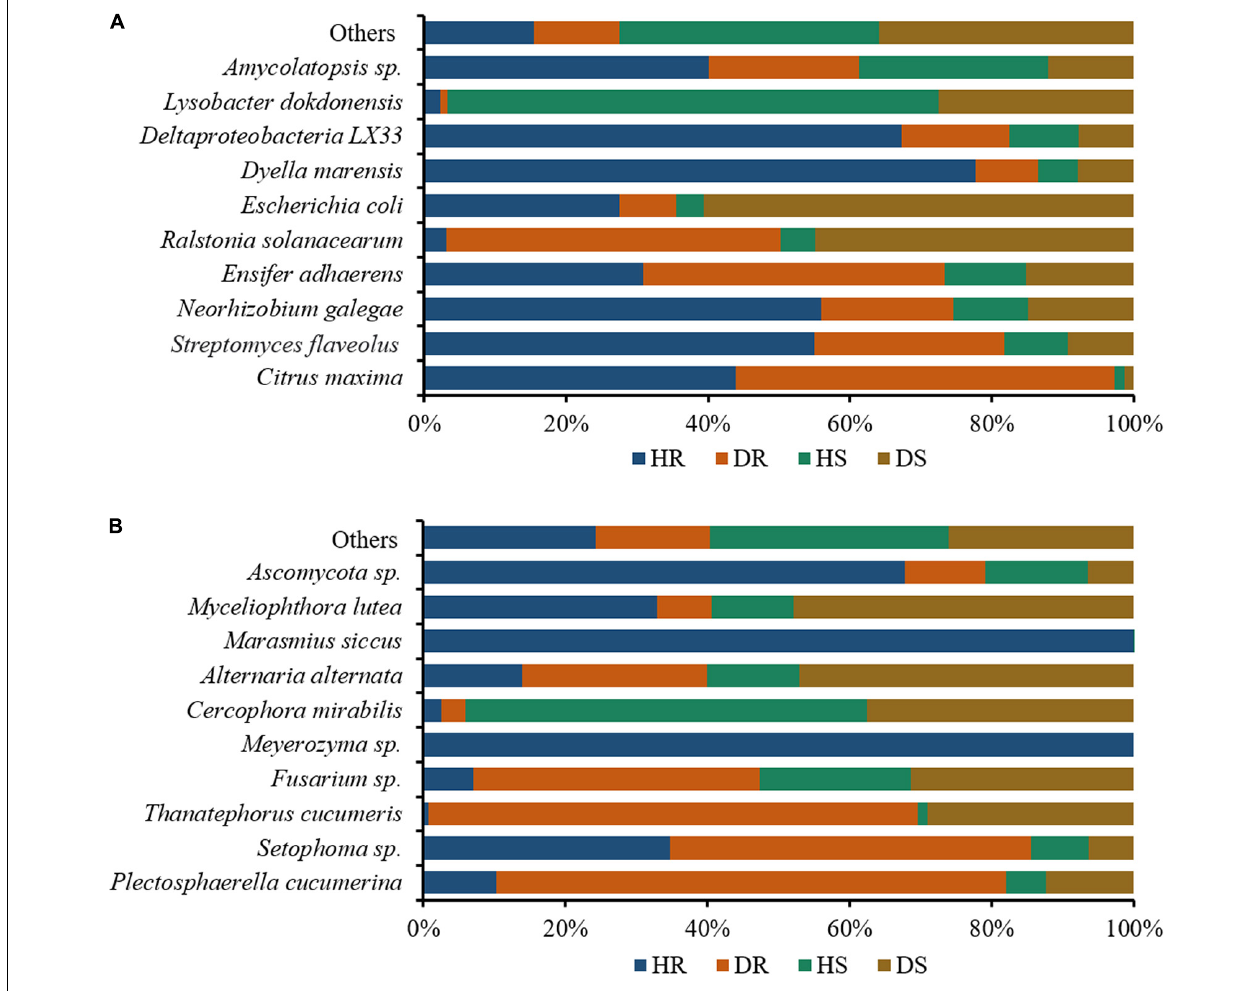
FIGURE 7 | Relative abundance bar plots for top 10 bacterial (A) and fungal (B) species in group-wise comparison under three variables. HS, healthy rhizosphere soil; DS, diseased rhizosphere soil; HR, healthy roots; DS, diseased